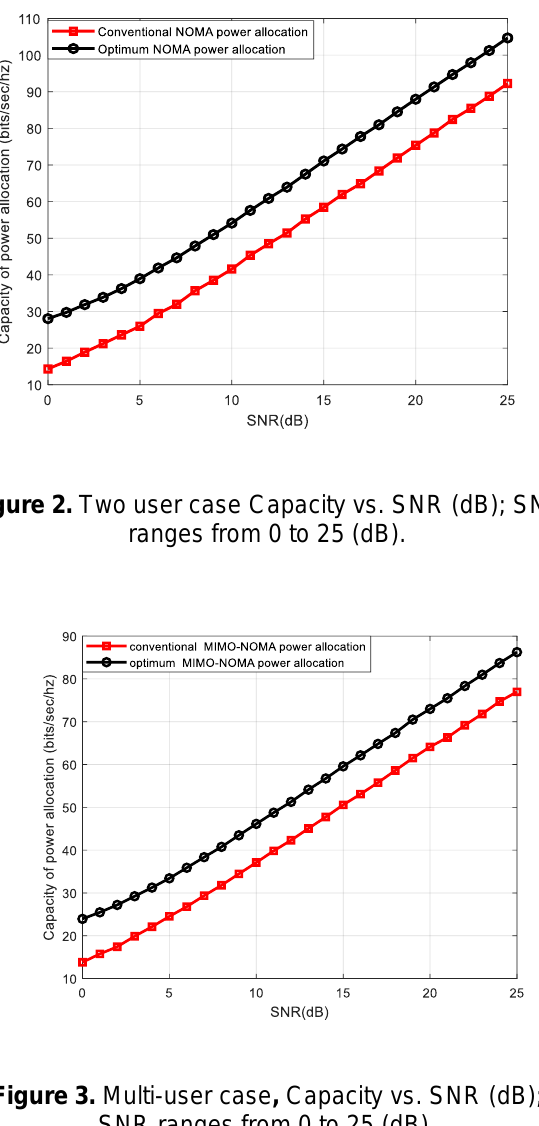
Figure 3. Multi-user case , Capacity vs. SNR (dB); SNR ranges from 0 to 25 (dB).